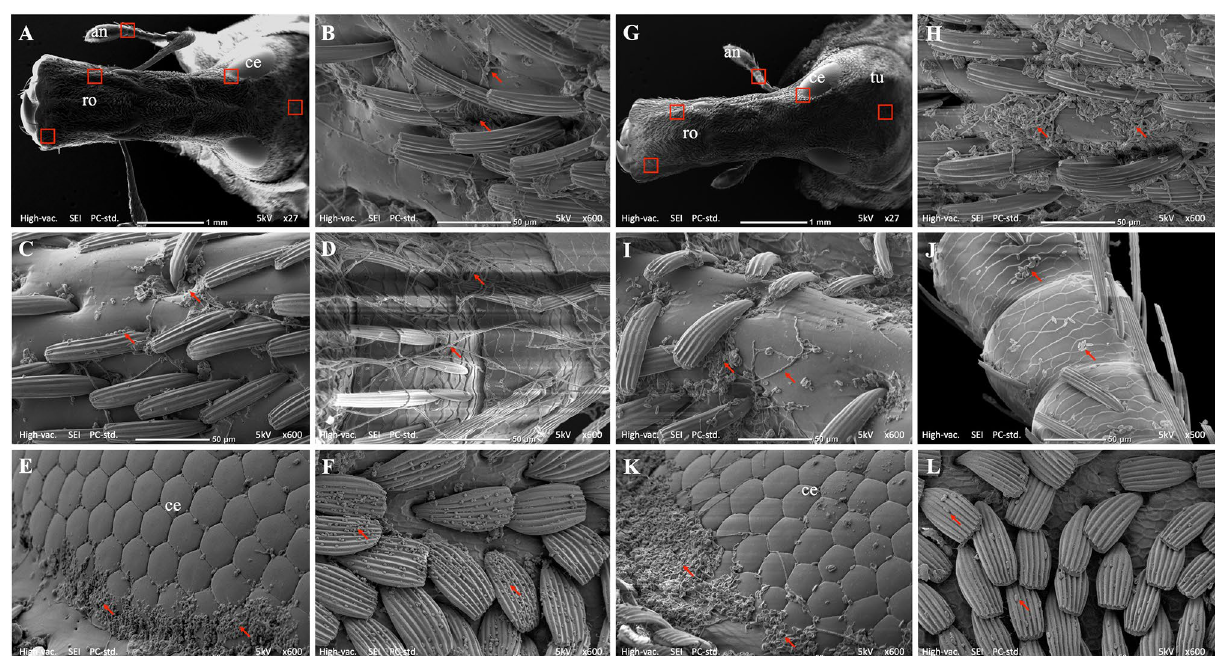
Figure 5. ( A , G ) Dorsal view of the head capsule showing antenna (an), compound eyes (ce), rostrum (ro) and tubercles (tu). Fungal conidia attached and/or germinated on ( B , H ) left side of rostrum, ( C , I ) right side of rostrum, ( D , J ) funicles of the antenna, ( E , K ) compound eyes and ( F , L ) scales on the head. The red arrows point at the conidia and/or the germinated conidia of B27 ( B – F ) and ECS1 ( H – L ); the red boxes in image A and G illustrates the parts of head capsule shown at higher magnification in images B – F and H – L , respectively. As there were numerous conidia either attached to, or germinated on the weevil, the arrows are used to indicate